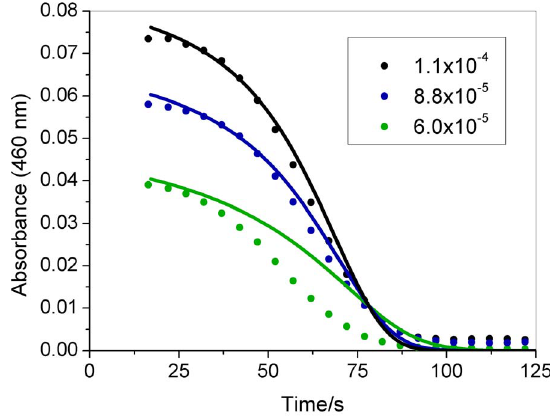
Figure 5. Effect of the iodine concentration on the clock time. Initial concentrations after mixing the reactants in the cuvette: [I 2 ] as indicated in the figure (mol L 2 1 ), [NaClO 3 ] = 0.0251 mol L 2 1 ,